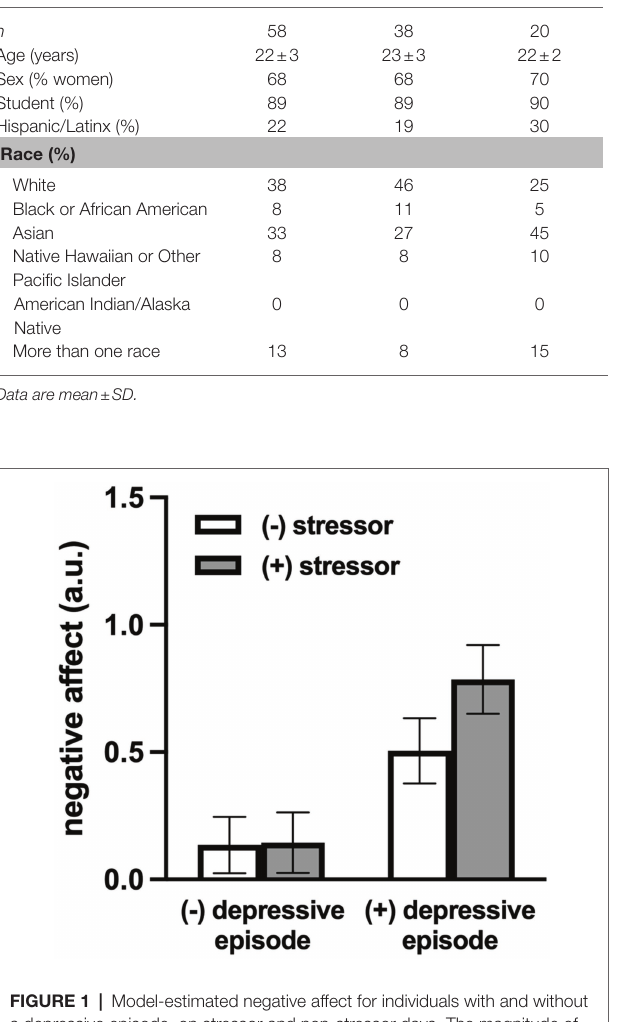
FIGURE 1 | Model-estimated negative affect for individuals with and without a depressive episode, on stressor and non-stressor days. The magnitude of the increase in negative affect on days with an exposure to a daily stressor was greater in adults with a depressive episode ( p = 0.02). Data are mean ±